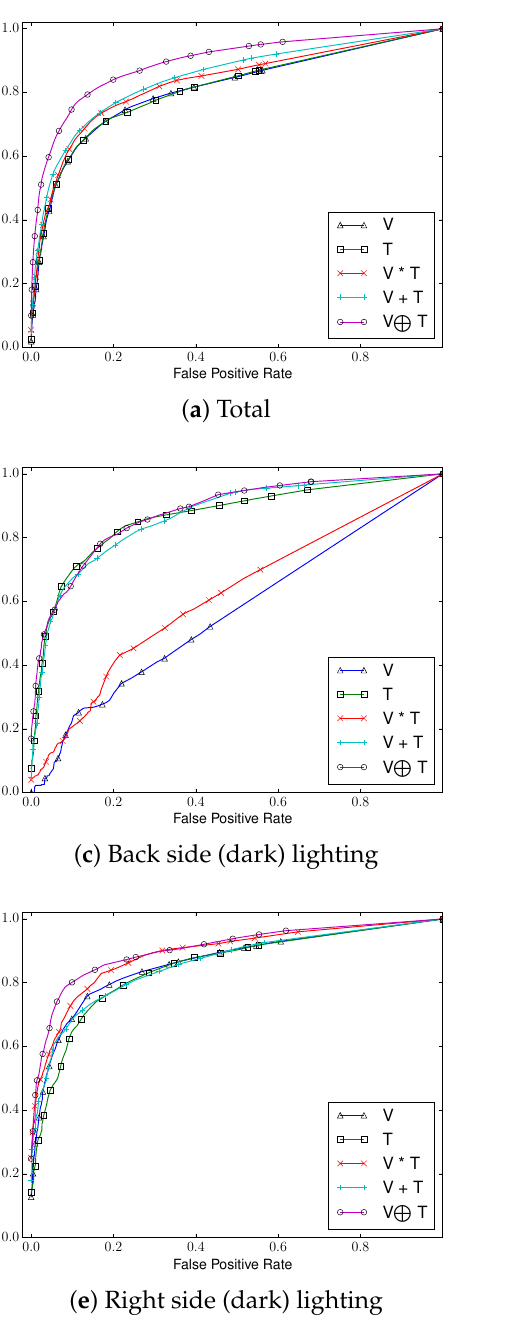
Figure 12. ROC curves of five compared methods in each lighting condition using Random Forests